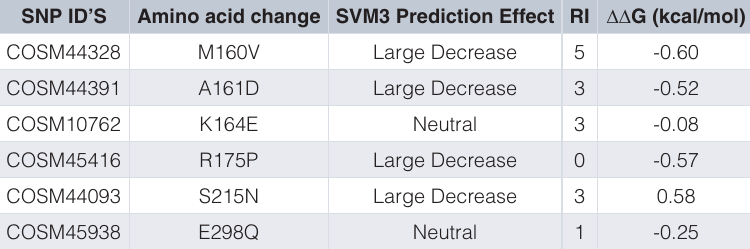
Table 6. Prediction of nsSNPs stability status by I Mutant 2.0